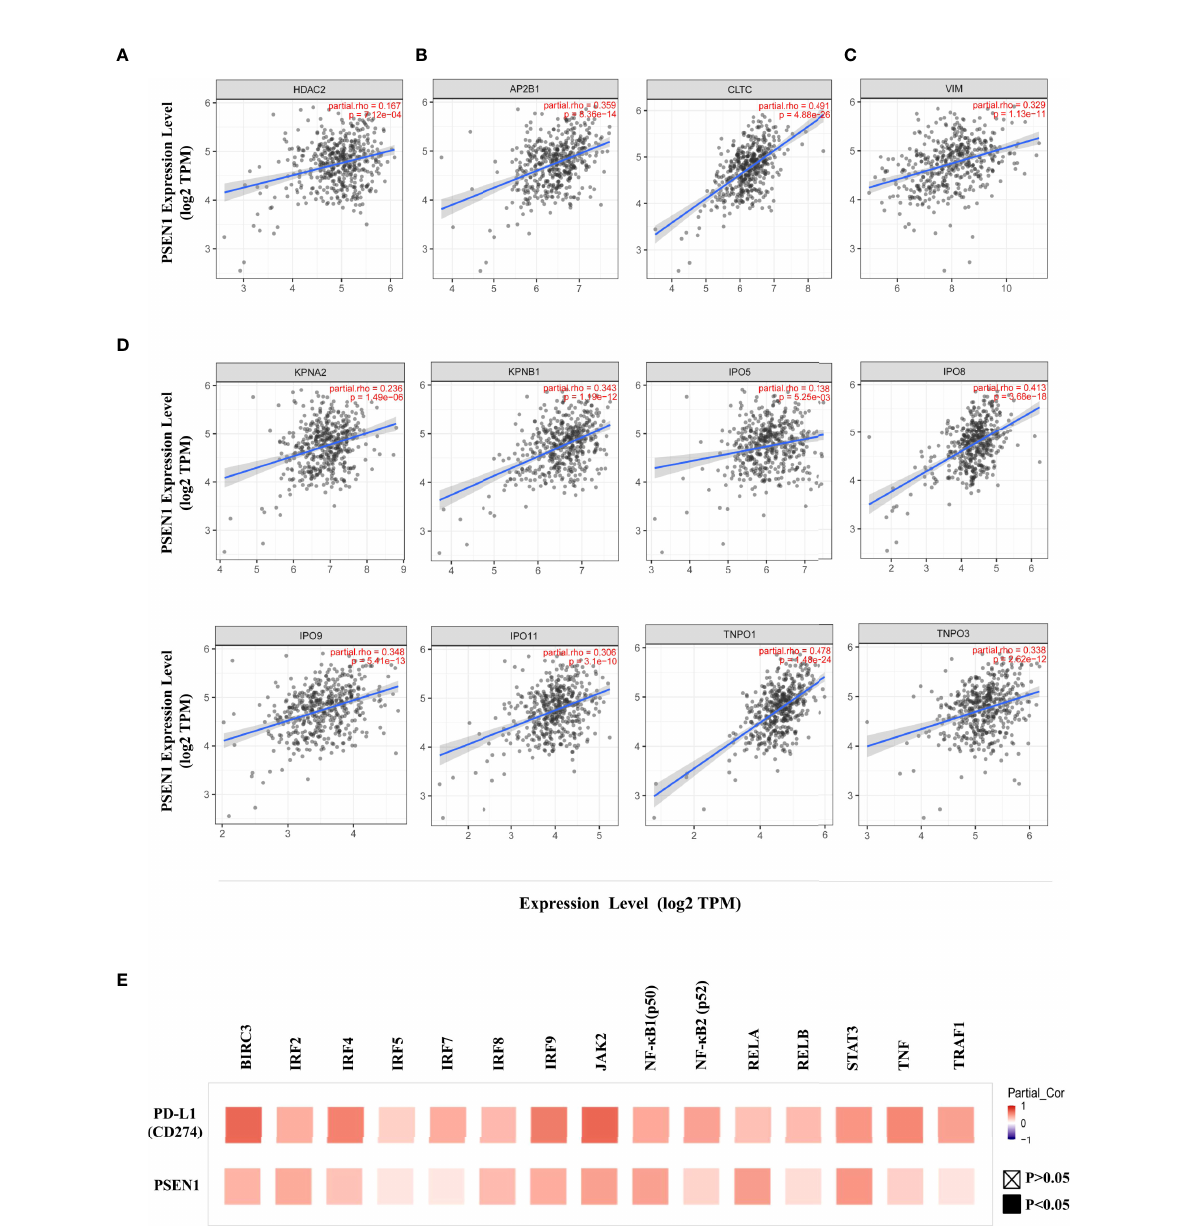
FIGURE 2 PSEN1 correlates with PD-L1 nuclear translocation in colon cancer. The correlations of PSEN1 with (A) HDAC2, (B) AP2B1 and clathrin (CLTC), (C) vimentin (VIM), (D) importin a 1(KPNA2), importin b 1 (KPNB1), importin 5 (IPO5), importin 8 (IPO8), importin 9 (IPO9), importin 11 (IPO11), transportin 1 (TNPO1) and transportin 3 (TNPO3) in COAD analyzed by TIMER2. Levels of the mRNA expression were normalized in Log2 TPM and the corresponding correlation coef fi cients and signi fi cance were indicated. (E) The correlations of PD-L1 (upper) or PSEN1 (lower) with the immune response genes in COAD analyzed by TIMER2 and shown in a heat map table of spearman ’ s correlation. Red indicates a statistically signi fi cant positive association, and blue indicates a statistically signi fi cant negative association. Gray denotes a non-signi fi cant result. P < 0.05, shown in solid squares and P > 0.05, shown in hollow